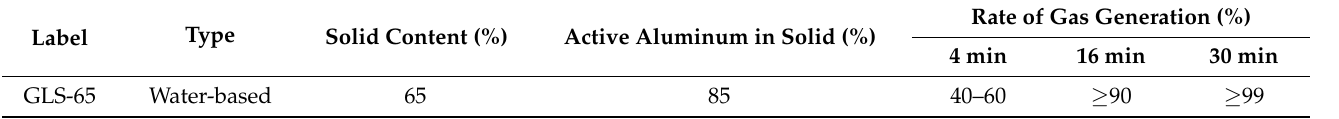
Table 3. Characteristics of aluminum powder-based expansion agent.